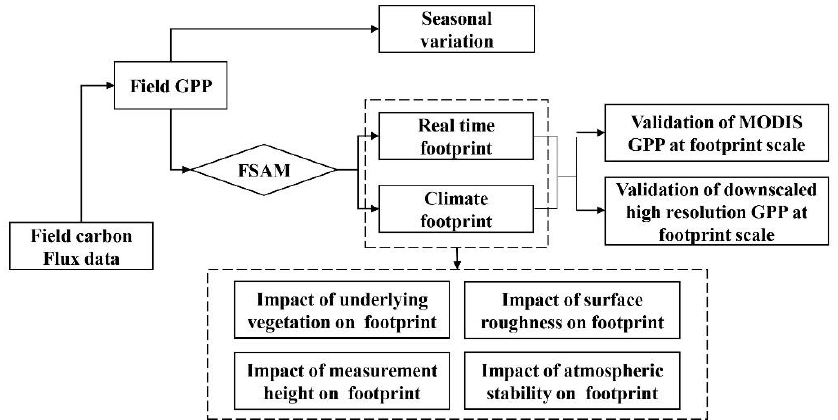
Figure 2. Flowchart for analyzing the spatial representativeness of field GPP. Real-time footprint and climate footprint were obtained using a flux source area model. MODIS GPP and downscaled high resolution GPP were validated at footprint scale. And the main impact factors of field GPP footprint were analyzed.